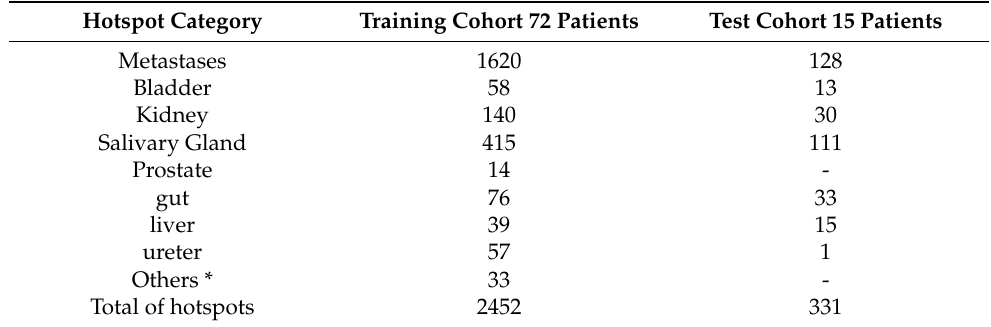
Table 4. The distribution of the hotspots over different body organs in the training and test cohorts. (* the others category refers to the rest of organs in which hotspots were